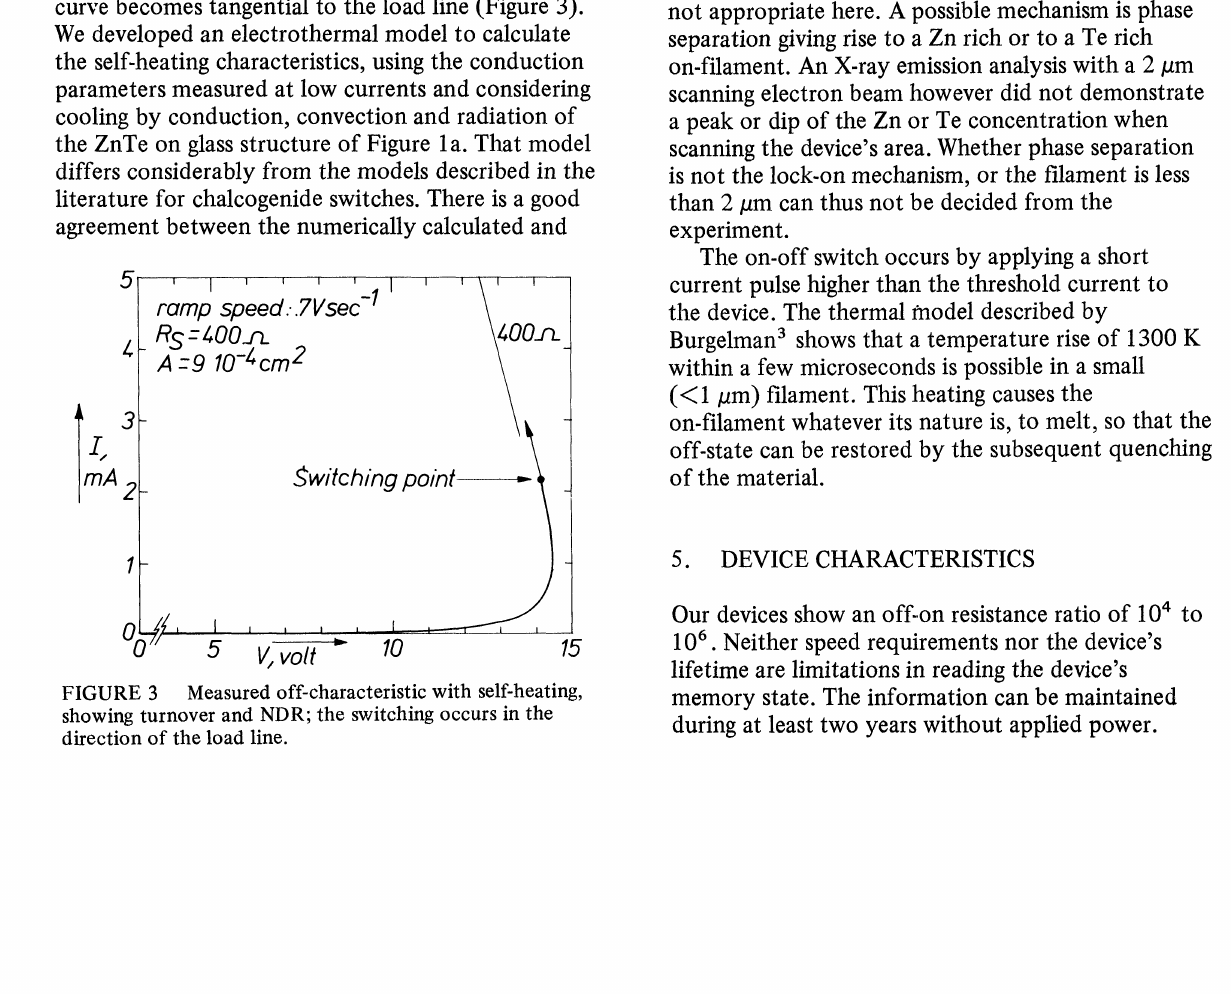
5 V, volt 10 Measured off-characteristic with self-heating, showing turnover and NDR; the switching occurs in the direction of the load